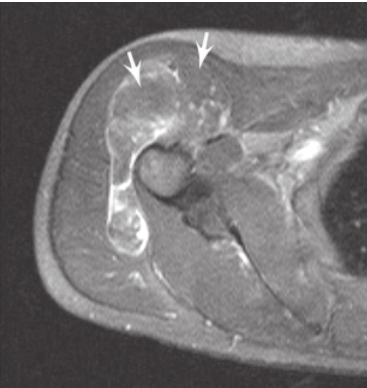
Figure 1c – Axial fat-suppressed T1-weighted MR image after intravenous injection of gadolinium-DTPA shows heterogeneous enhancement, predominantly in corresponding to T2-hyperintense (likely myxoid) areas (arrows)